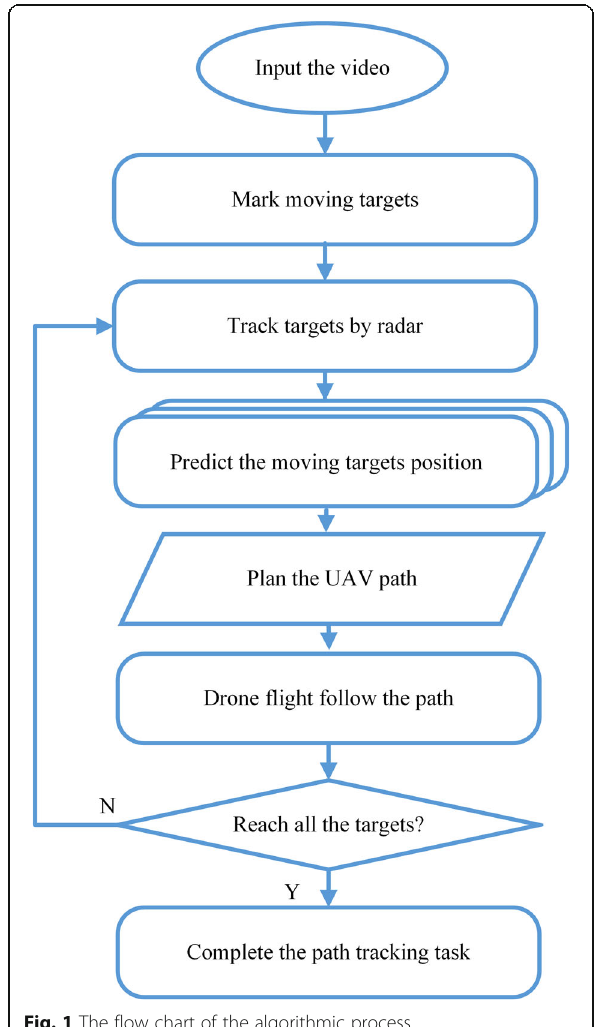
Fig. 1 The flow chart of the algorithmic